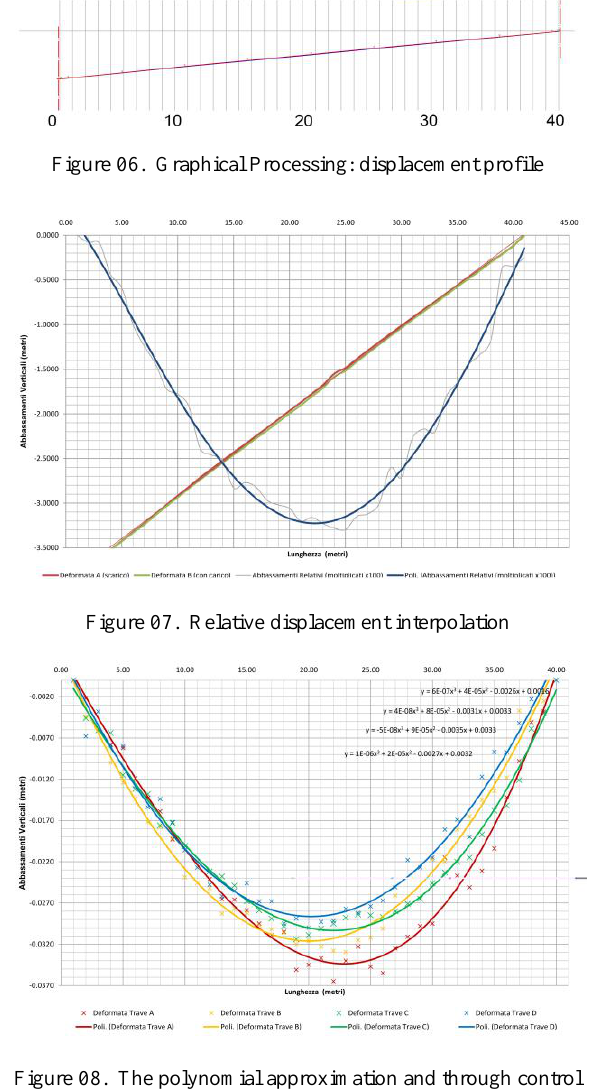
Figure 08. The polynomial approximation and through control points chosen at regular